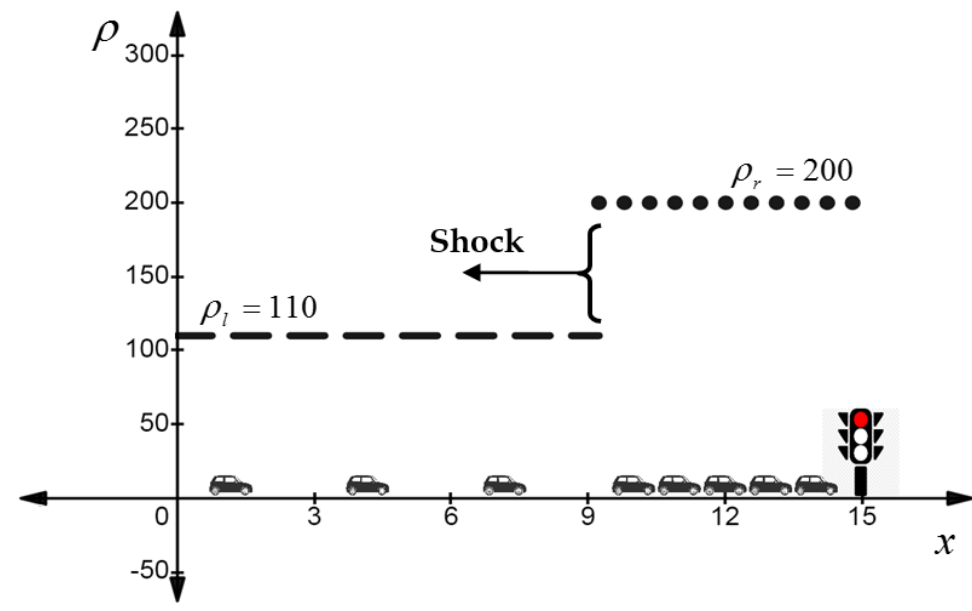
Table 1. Shock location and speed for various fractional-order values.